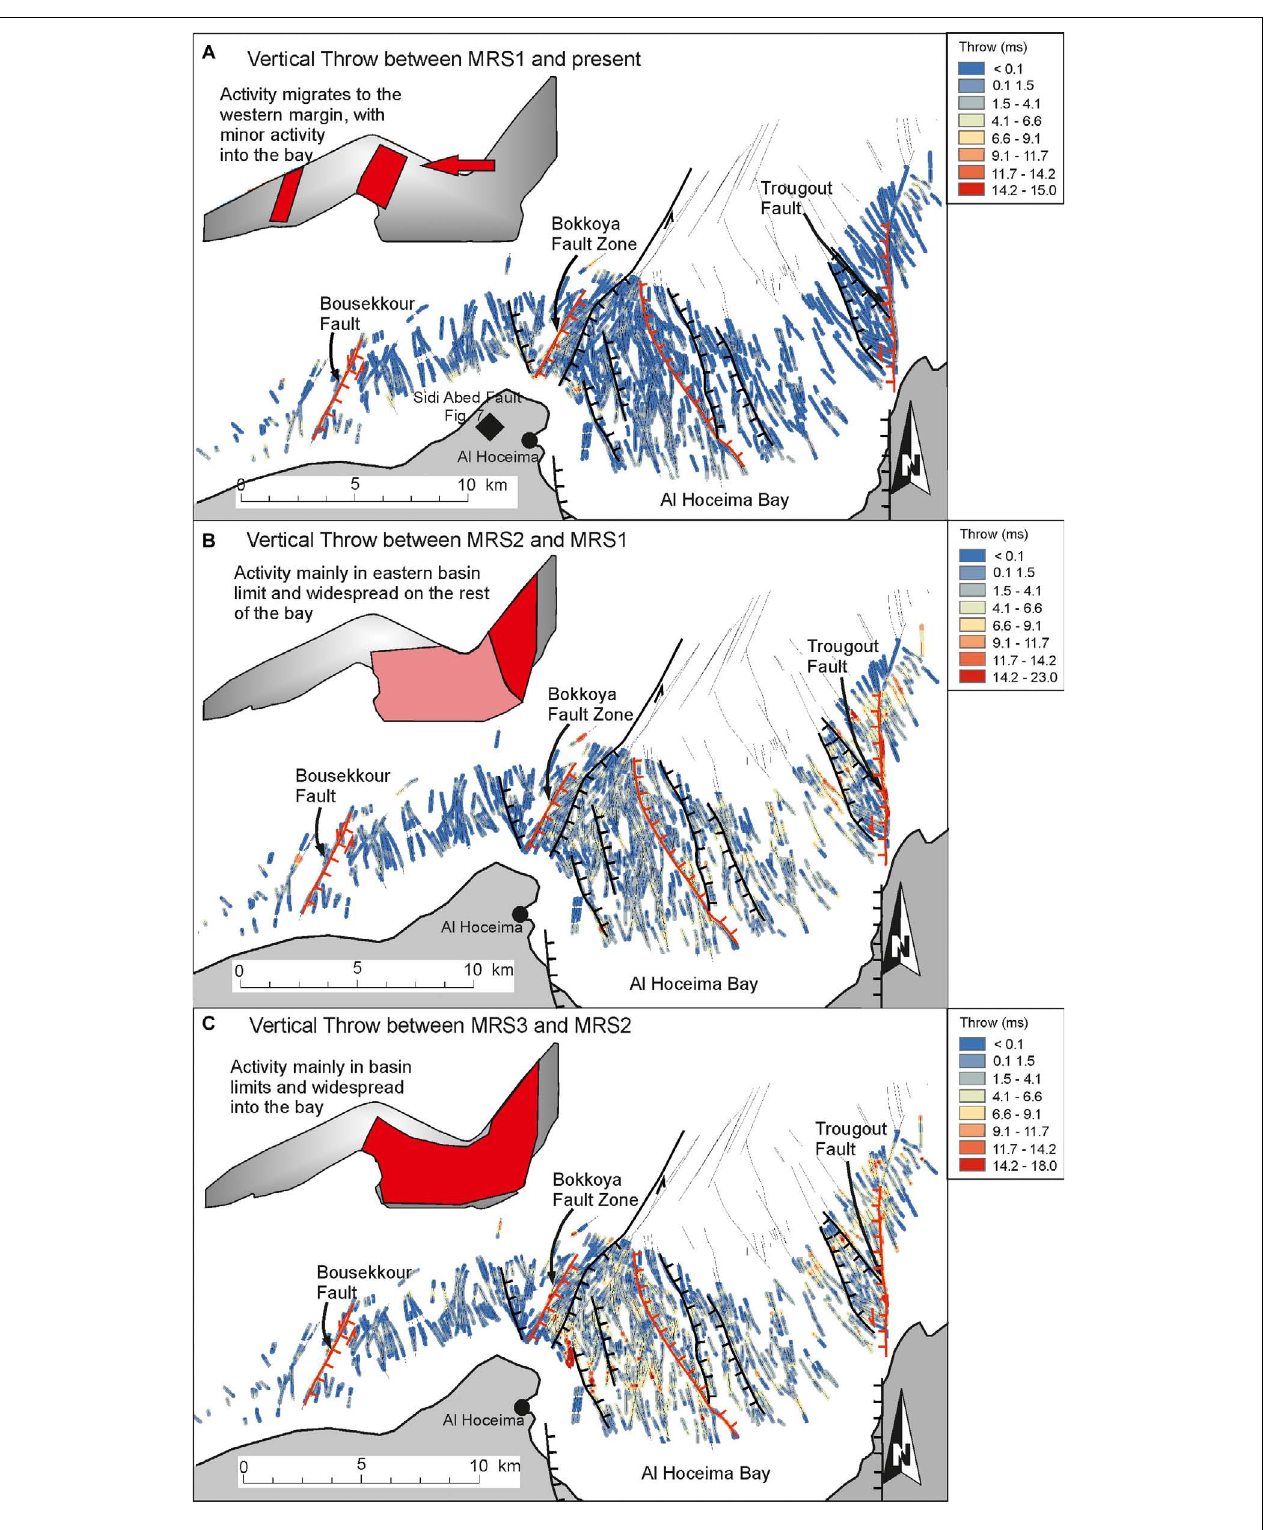
FIGURE 5 | Throw maps in milliseconds (ms), including the traces of faults from Lafosse et al. (2016, 2018). (A) Between MRS1 and present days. (B) Between MRS2 and MRS1. (C) Between MRS3 and MRS2. The maps in the top left corner are outlines of broad areas with major tectonic activity for each period. These areas have been simplified from the detailed throw maps. The main faults traces are also depicted; those in red are the fault traces used for the throw-length profiles of Figure 6 .